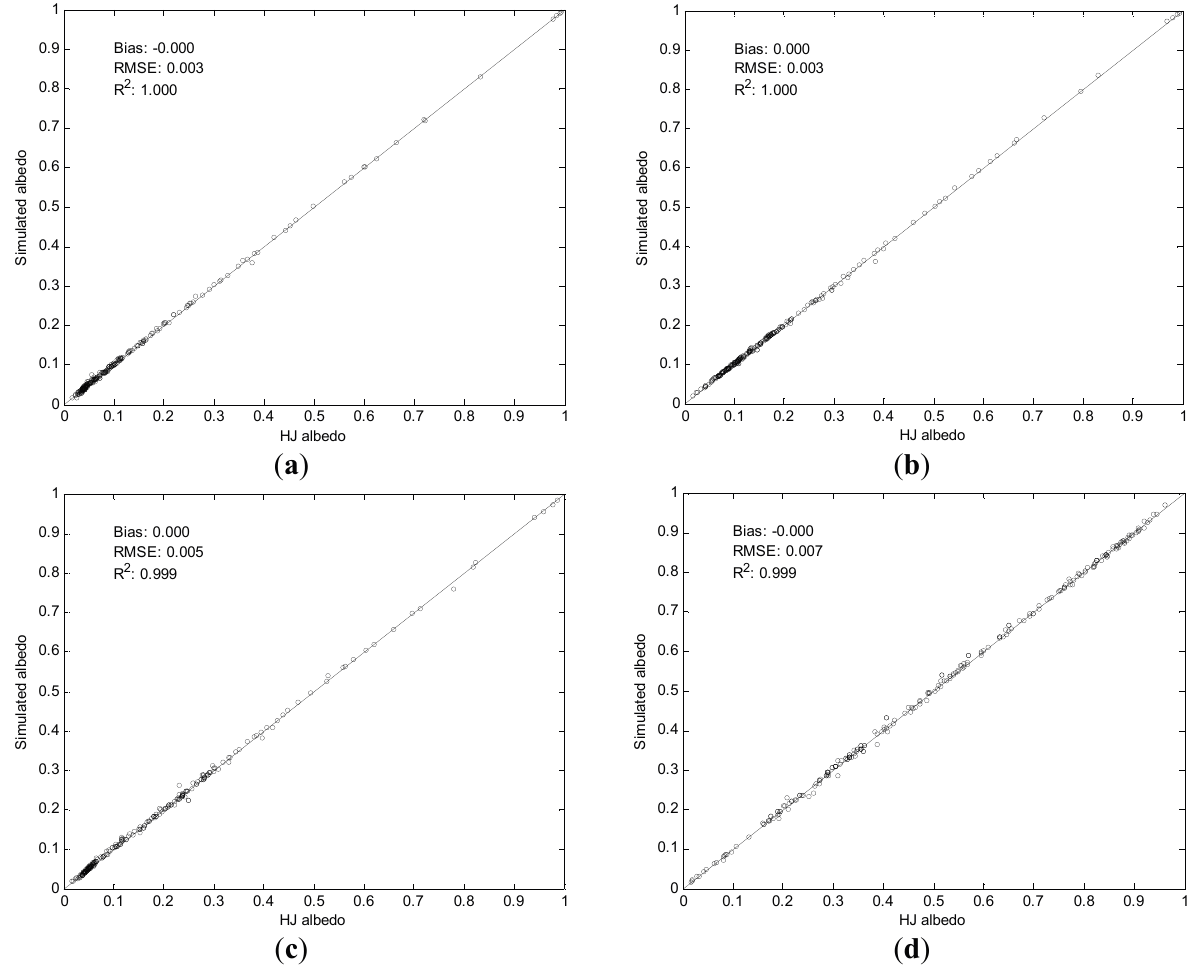
Figure 3. Comparison of HJ spectral albedos and the values estimated from the simulated MODIS spectral albedos using Equations (2)–(5): ( a ) HJ band 1; ( b ) HJ band 2; ( c ) HJ band 3; and ( d ) HJ band 4. All 245 spectrum samples are included in the scatter